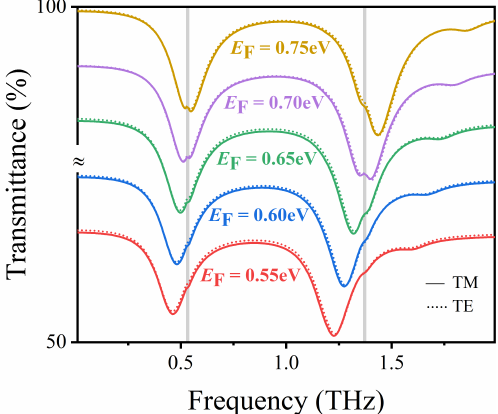
Figure 13. Transmission spectra of lactose covered DAIGS at different Fermi energies under TE or TM incidence